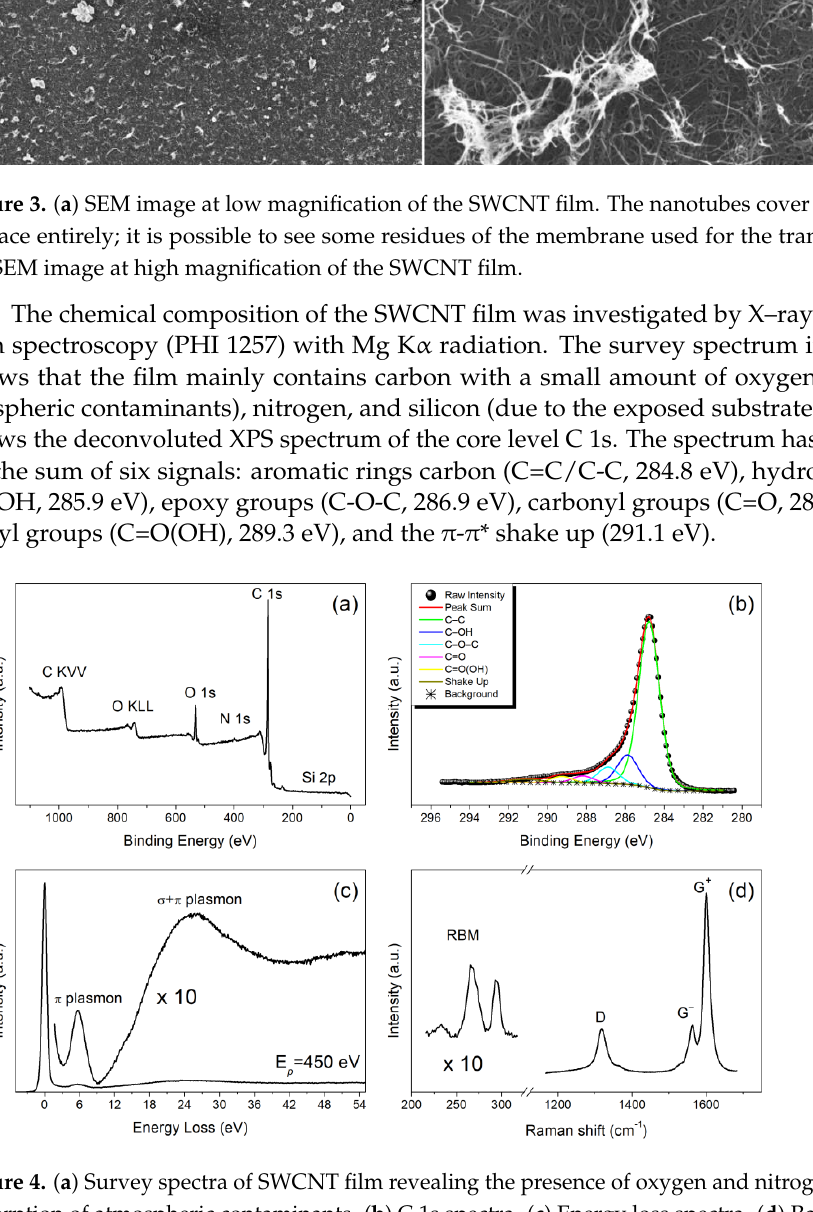
Figure 4. ( a ) Survey spectra of SWCNT film revealing the presence of oxygen and nitrogen due to